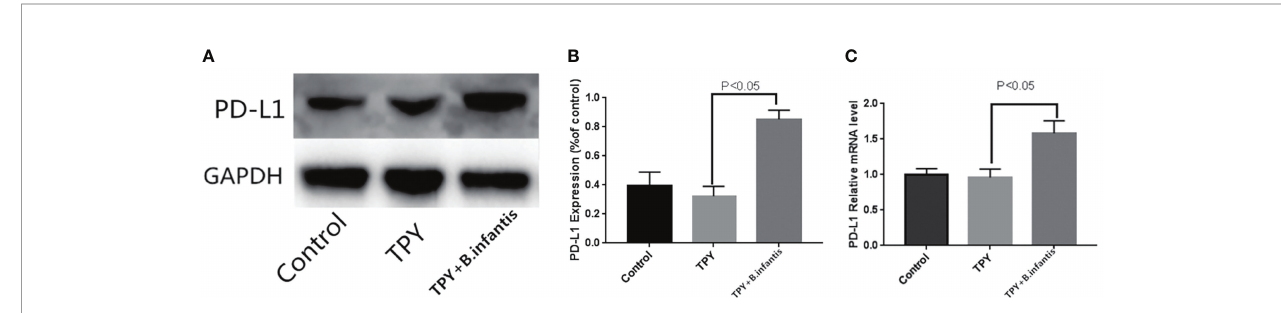
FIGURE 2 | Effect of Bi fi dobacterium infantis supernatant on PD-L1 expression. (A) PD-L1 protein expression band. (B) Differences in PD-L1 protein expression. (C) Differences in PD-L1 mRNA expression. The data in the fi gure are expressed as mean ± standard deviation, and the sample comparison among the groups was conducted using one-way ANOVA. P < 0.05 was considered statistically signi fi cant.